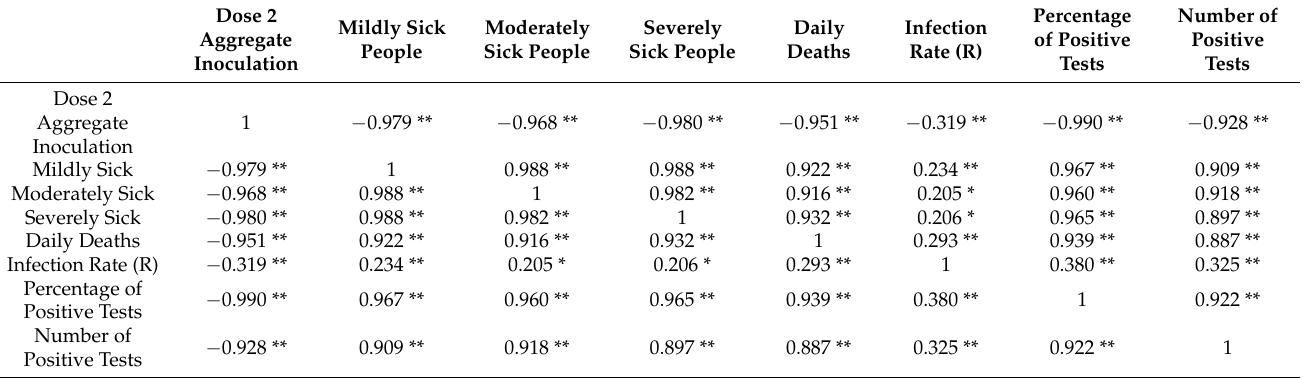
Table 6. Correlation between dose 2 and the sickness factors from 13 January 2021 to 21 May